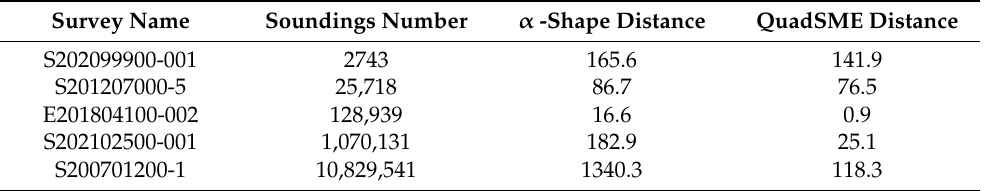
Table 1. Computation of the Hausdorff-Pompeiu distance (in meters) for five bathymetric